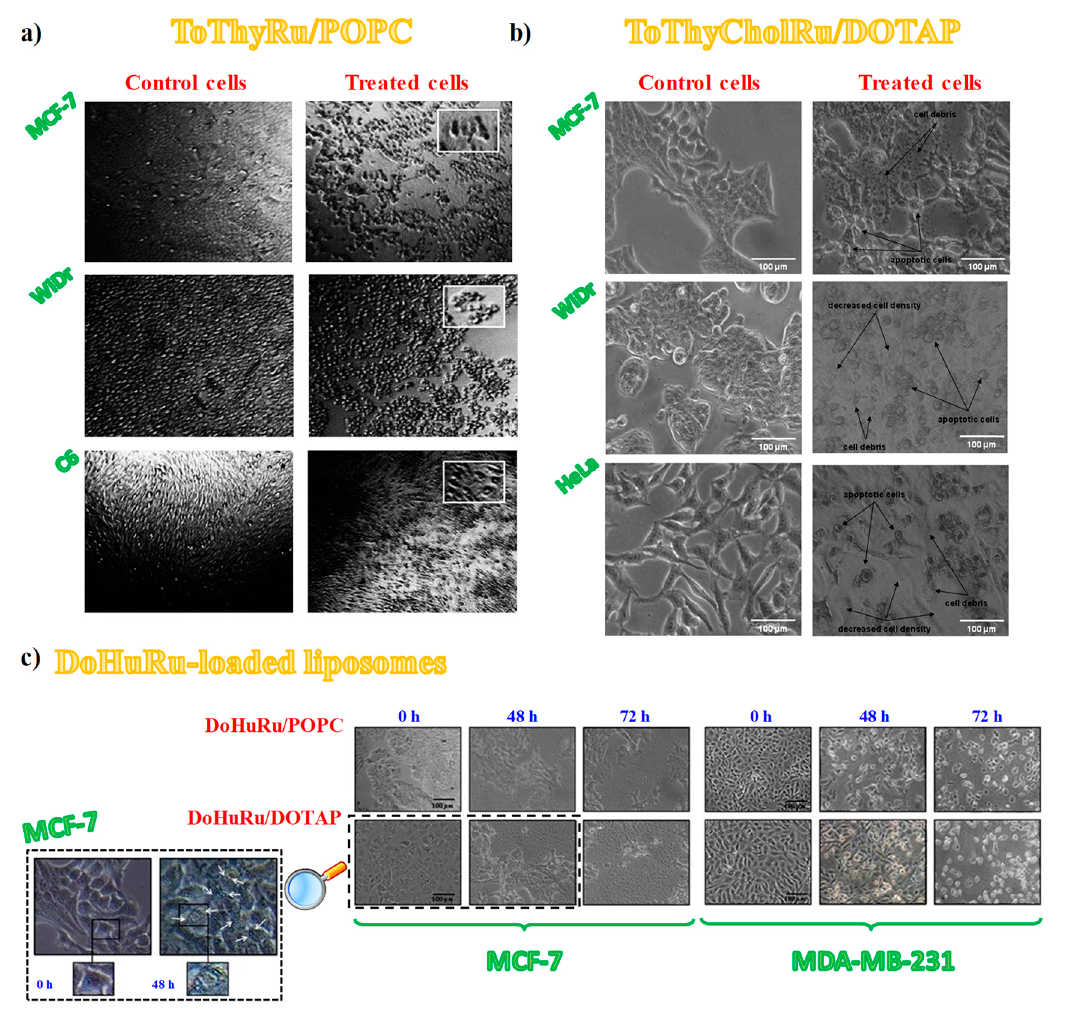
Figure 9. Representative photomicrographs by phase-contrast light microscopy showing the cellular morphological changes and cytotoxic e ff ects on cellular monolayers: untreated (left column in panels a and b ) or treated for 48 h with ToThyRu / POPC ( a ) or ToThyCholRu / DOTAP ( b ) formulations. For ToThyRu / POPC nanosystems, MCF-7, WiDr and C6 cancer cell lines were examined ( a ); in turn, for ToThyCholRu / DOTAP nanocarriers, MCF-7, WiDr and HeLa cancer cell lines were analysed ( b ). Insets in (a) represent higher magnifications of injured cells following incubations with ToThyRu / POPC liposomes. ( c ) MCF-7 and MDA-MB-231 breast cancer cells treated for 48 and 72 h with ruthenium IC 50 concentrations of DoHuRu-containing liposomes. The inset in (c) represents higher magnifications at 0 (left panel) and 48 h (right panel) DoHuRu / DOTAP treated MCF-7 cells, showing the formation of autophagic vacuoles detectable in cell cytoplasm. Figures are adapted from [77] ( a ), [79] ( b ) and [134] ( c ).